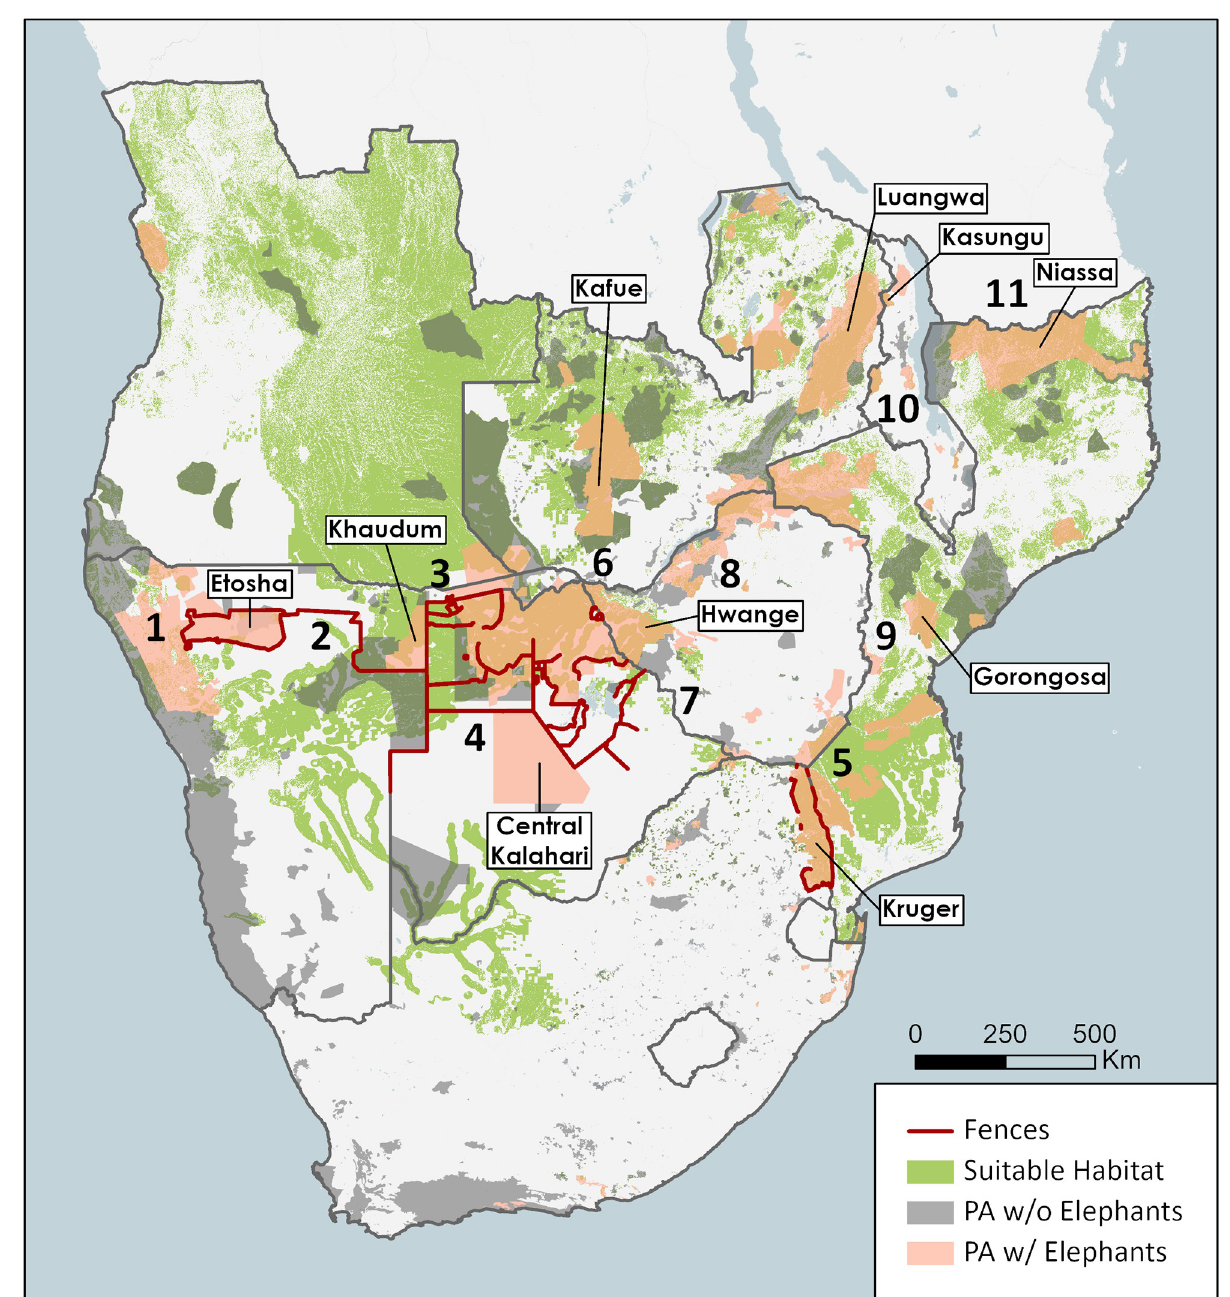
Fig 9. Map of notable routes of connectivity or lack thereof. Predicted suitable habitat (green), protected areas with elephants (orange), and protected areas without elephants (grey). The numbers refer to interesting connections and are described further in the main text.